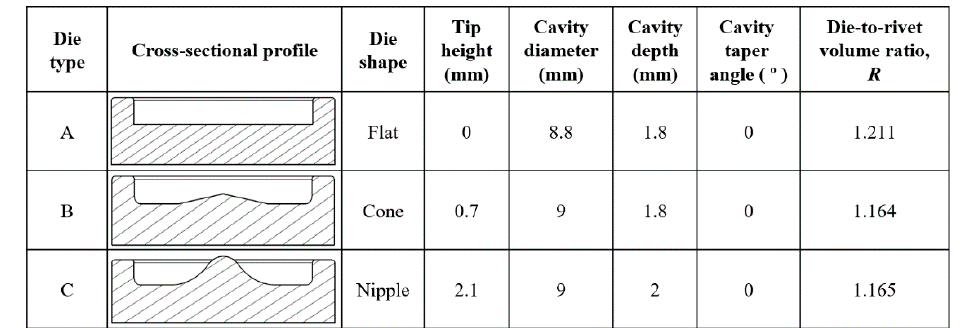
Figure 2. Geometric dimensions of the rivet used in this study. Figure 3. The geometric details of the die types used in the self-piercing riveting (SPR) process.